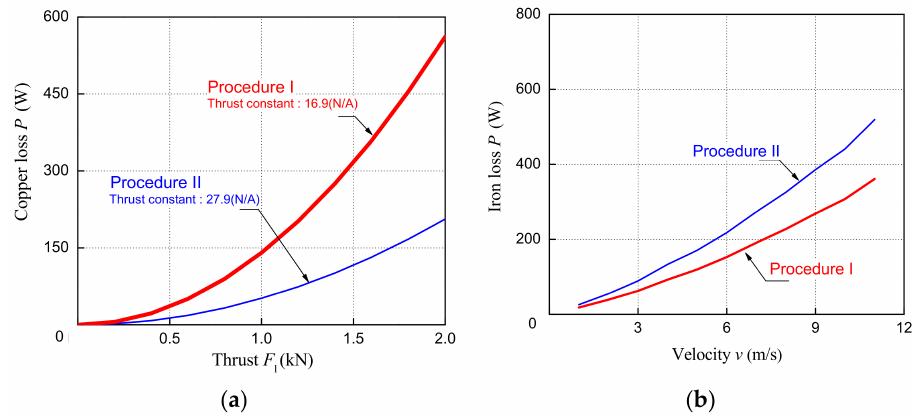
Figure 12. Loss of linear generators: ( a ) copper loss, ( b ) iron